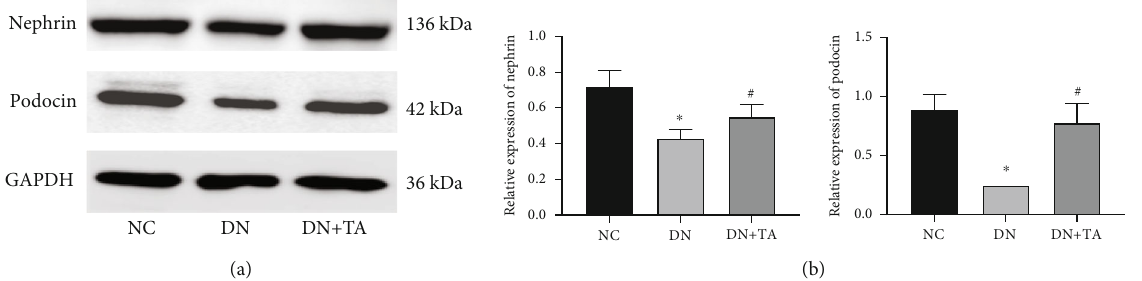
Figure 6: TA administration exhibited a protective e ff ect on podocyte damage in DN. (a) Representative western blots for Nephrin and Podocin protein expressions. (b) Quanti fi cation of Nephrin and Podocin protein expressions. All data are presented as mean ± SD . ∗ P < 0 : 05 versus NC group; # P < 0 : 05 versus DN